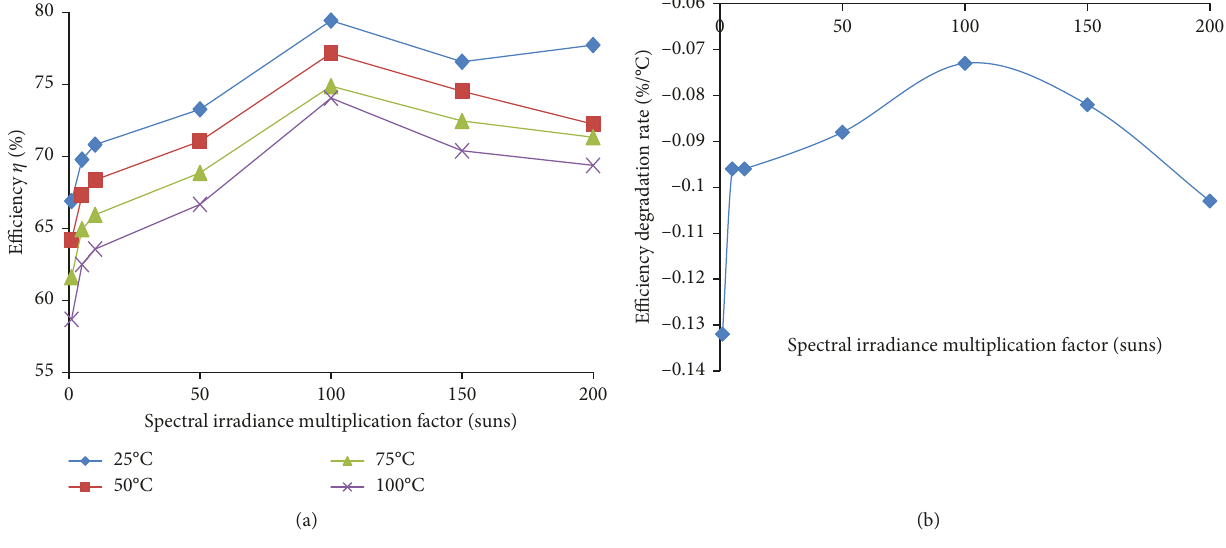
Figure 3: The effect of spectral irradiance multiplication on (a) the total efficiency of solar cells and (b) the efficiency degradation rate of solar cells.